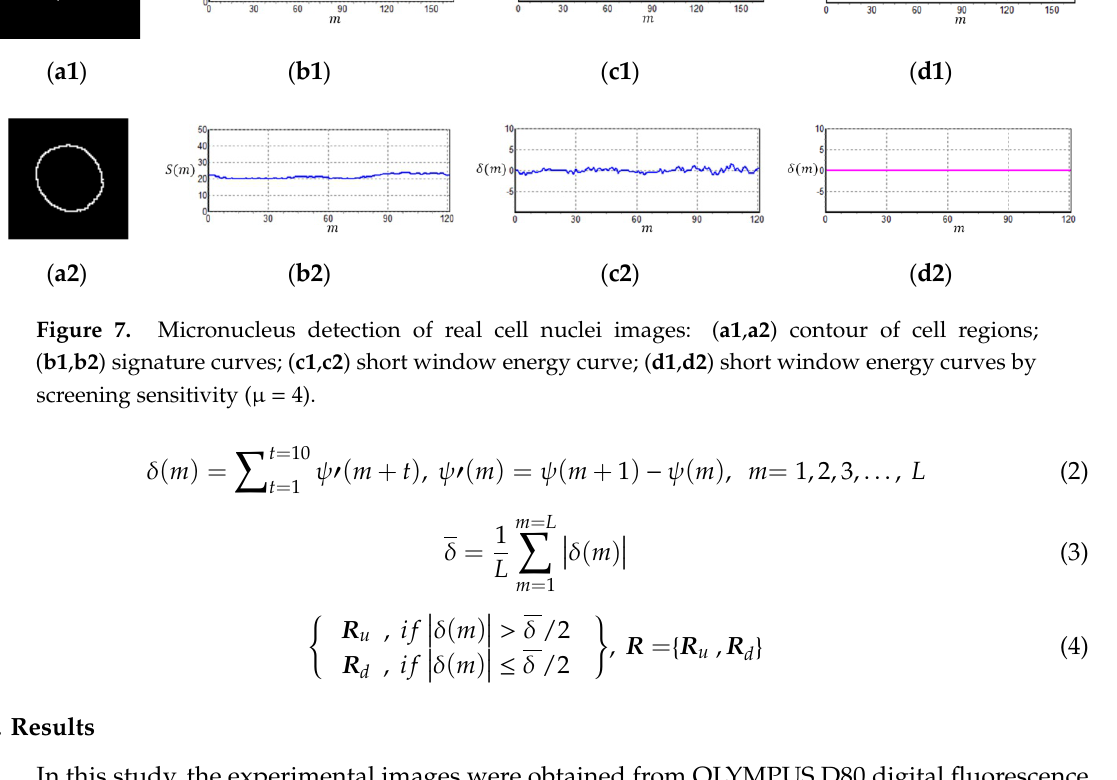
Figure 6. Short window energy curve and regions